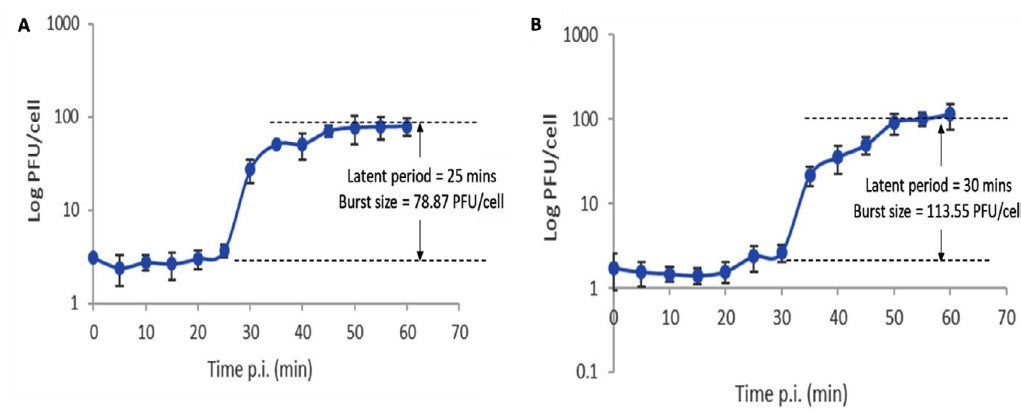
Fig. 2. One-step growth curves of phages vB_SauM-EG-AE3 (A) and vB_EfaP-Ef01 (B) on their corresponding hosts. Data shown are the mean of three replicates and error bars show the deviation in the Table 2. Dimensions of the isolated phages Phage